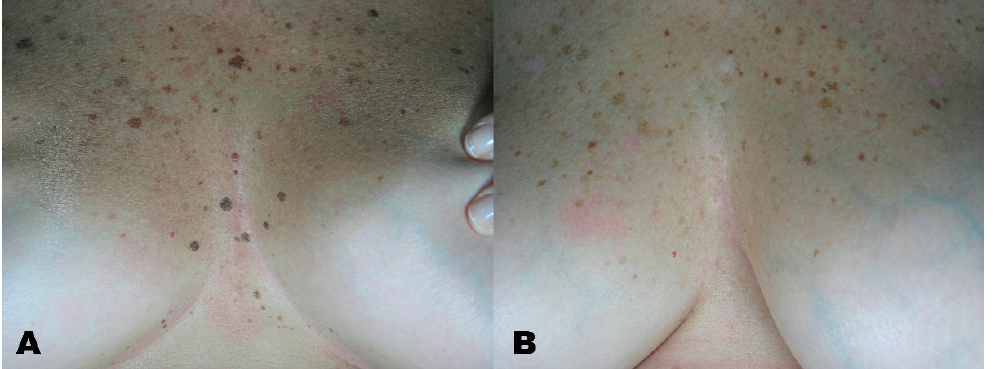
Figure 2. ( A ) Seborrheic keratosis before treatment. ( B ) Region after removal with Erbium laser.